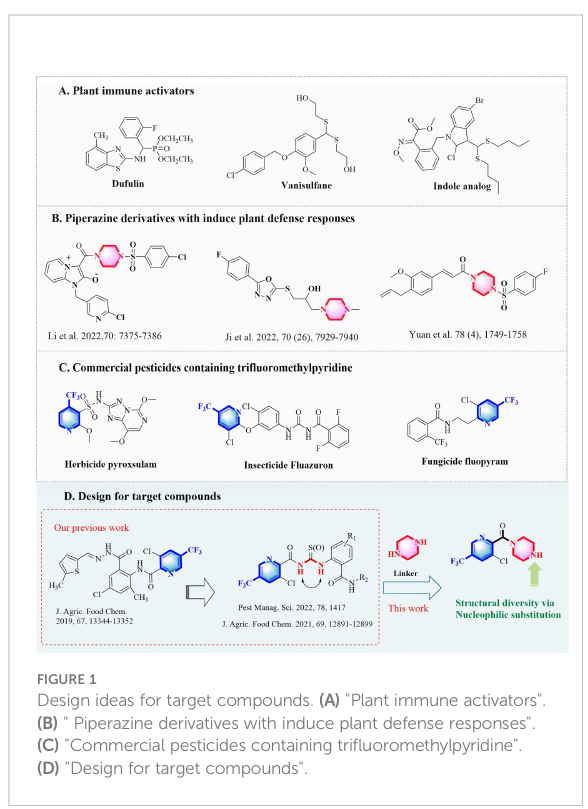
FIGURE 1 Design ideas for target compounds. (A) "Plant immune